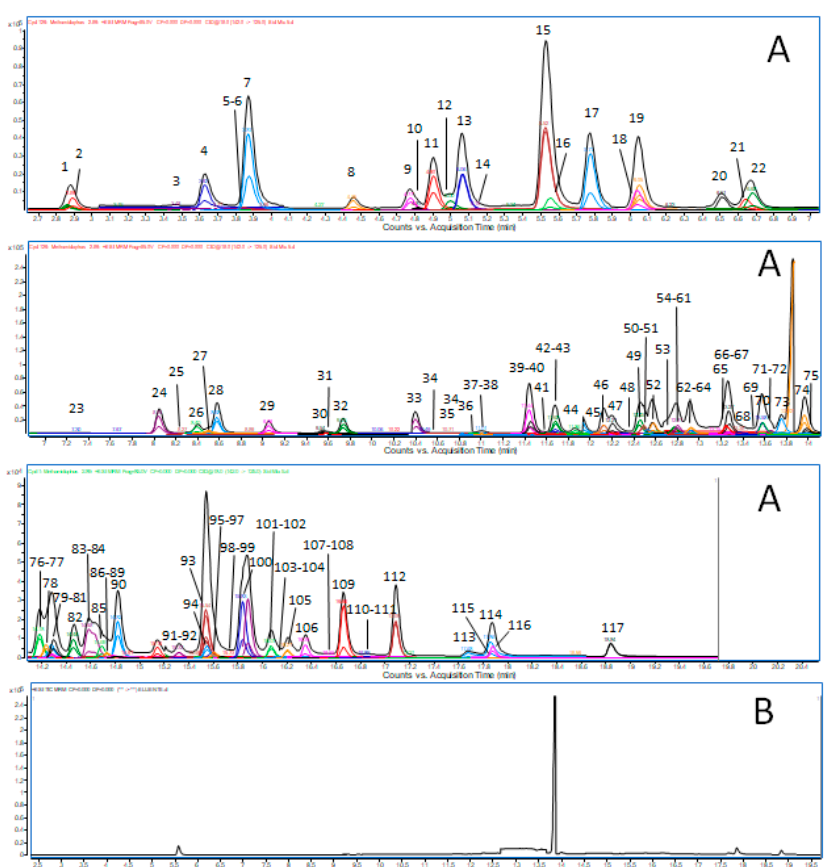
Figure 1. MRM condensed chromatogram at LOQ value of the 116 pesticides analyzed in the present study ( A ), and blank matrix ( B ).